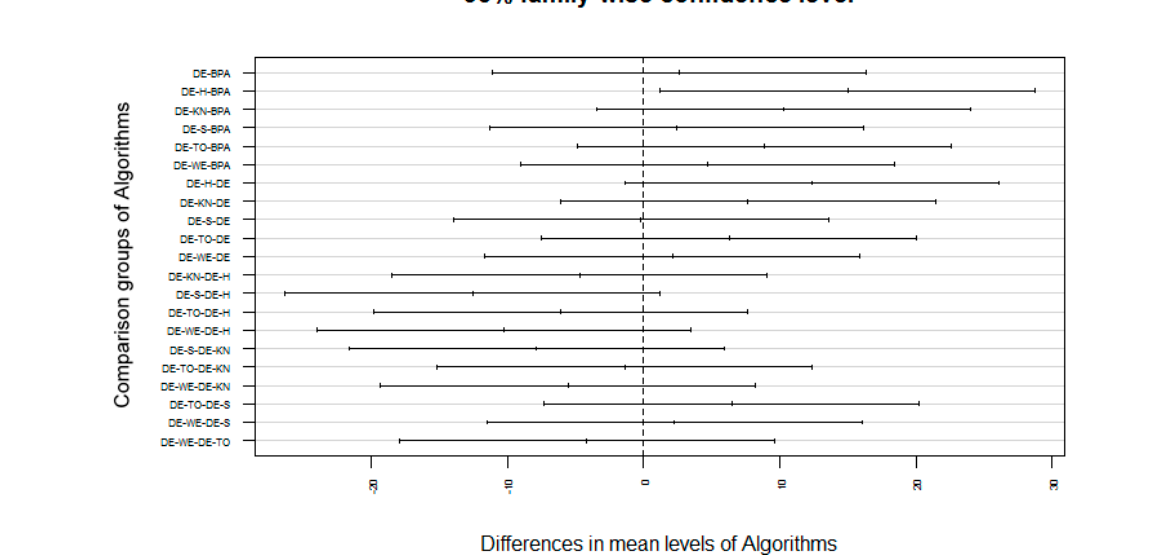
Figure 43. Boxplot visualization of the results achieved by the training of FFNN for all DE-based initialization approaches and BPA for given data set of classification problem.